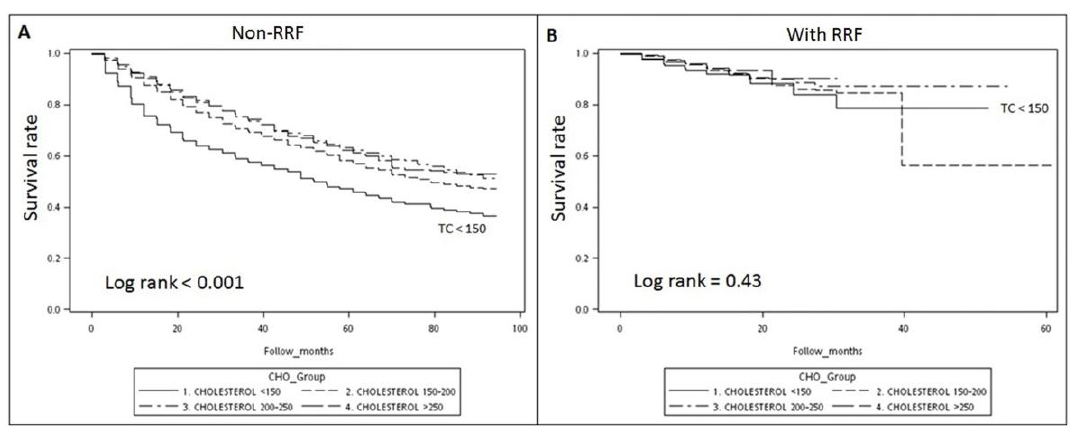
Figure 2. The Kaplan–Meier curve showing that hypocholesterolemia (TC < 150 mg/dL) in patients without RRF ( A ) had the worst survival rate, but not in patients with RRF ( B ).